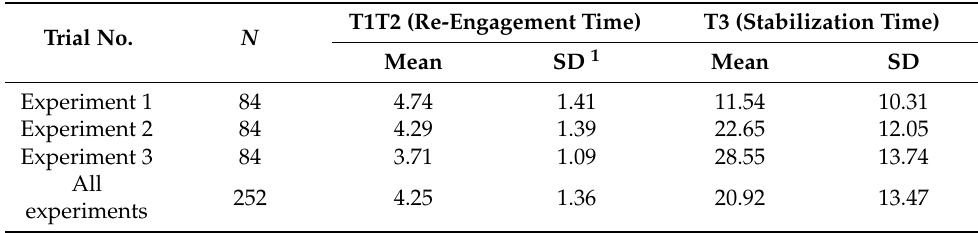
Table 2. Statistical analysis results for transition time.